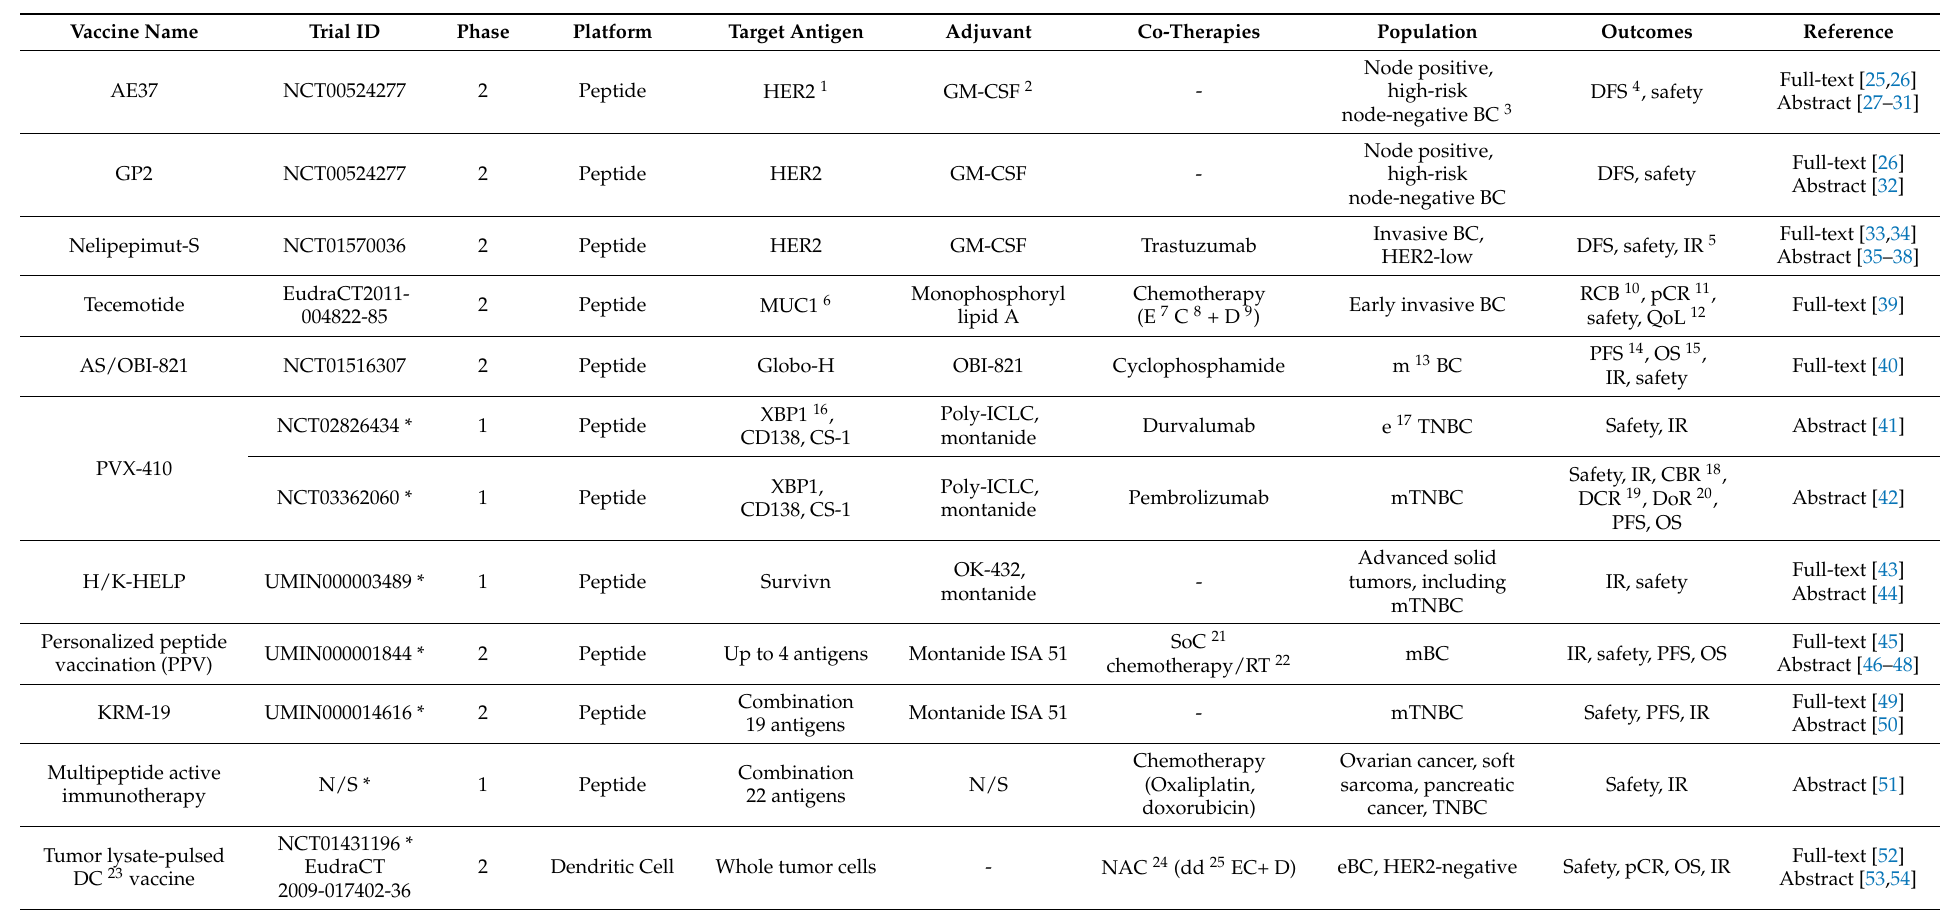
Table 1. Cancer vaccines currently evaluated in TNBC for safety/efficacy, based on included results. Non-randomized trials are marked with